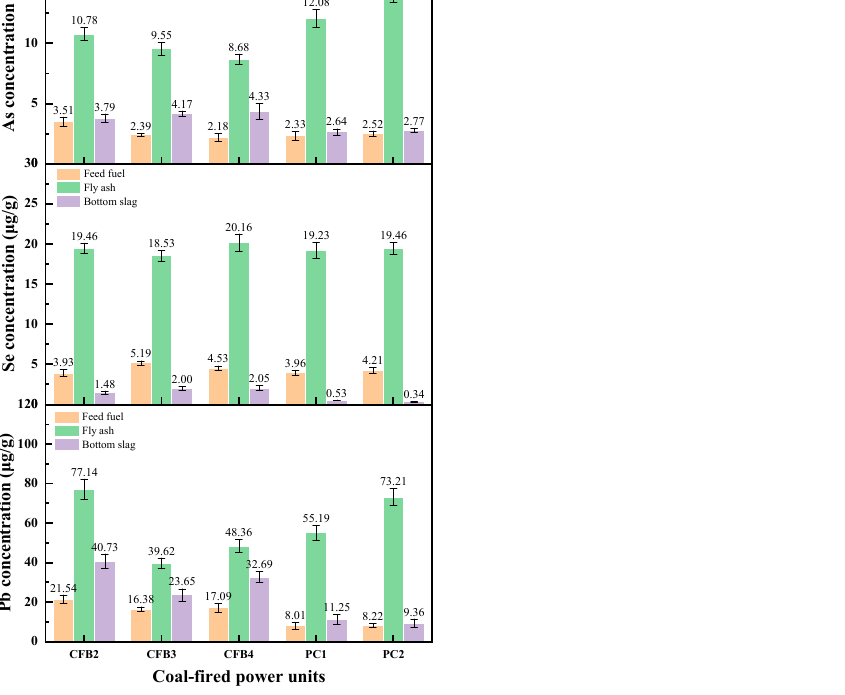
Figure 2. Distribution characteristics of As, Se and Pb in feed coal, fly ash and bottom slag of coal-fired power units.